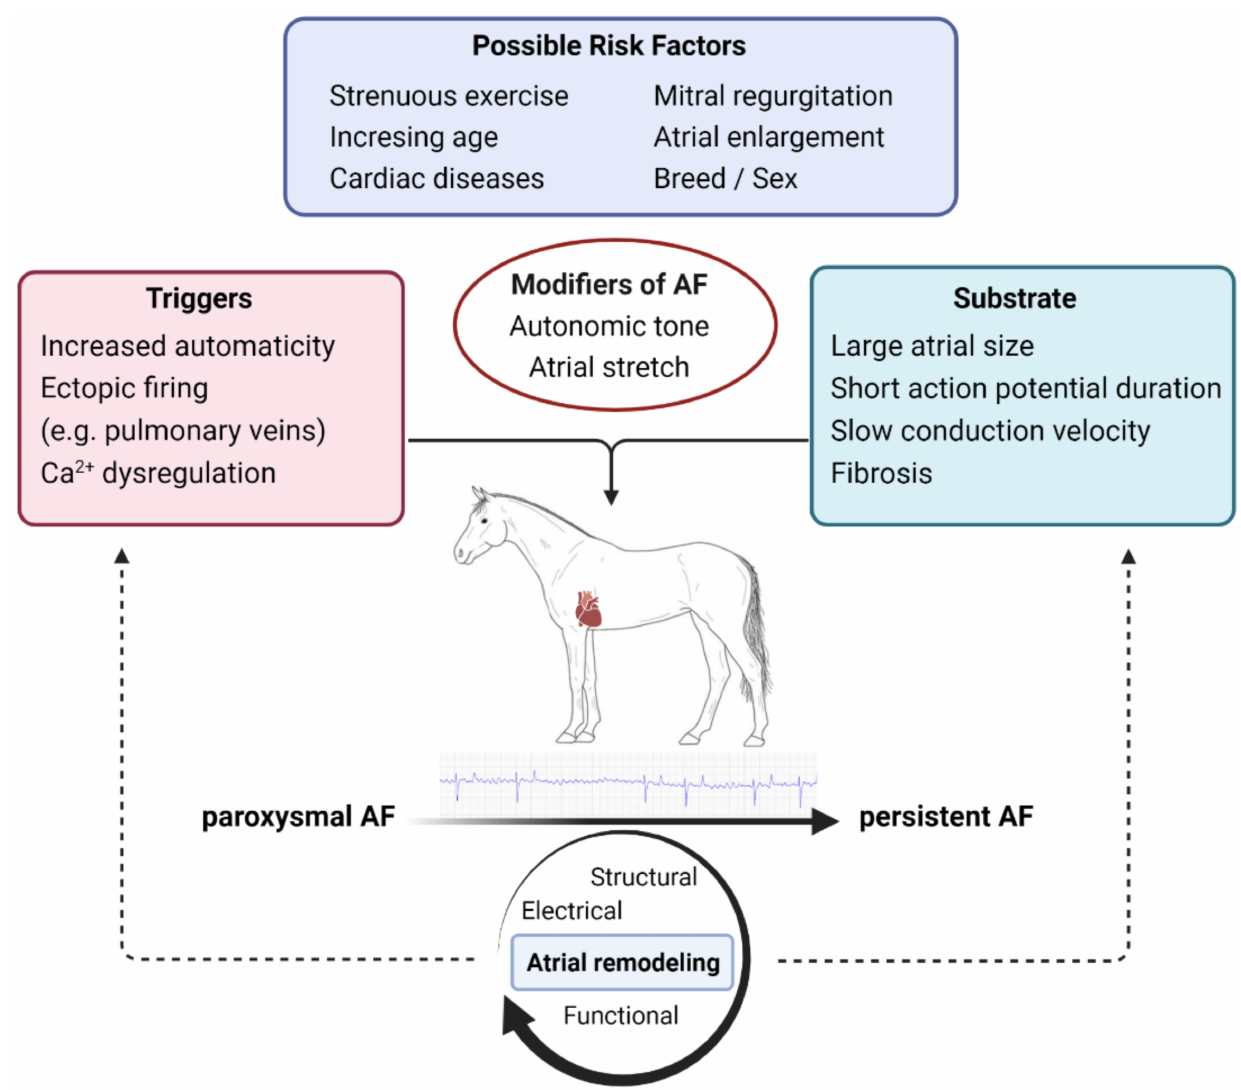
Figure 1. Possible risk factors and pathophysiology, including the triggers and substrate involved in the onset of paroxysmal atrial fibrillation (AF) and the progression to persistent AF in horses. Created with https://biorender.com/ (accessed on 2 March